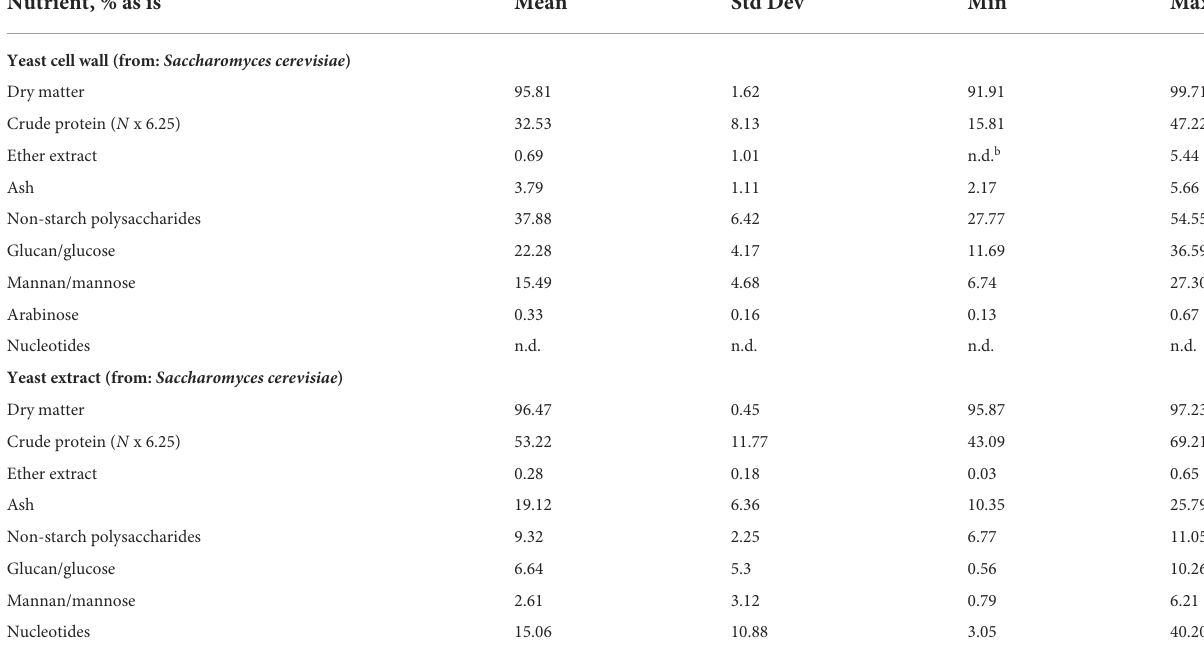
TABLE 2 Nutrient composition of yeast derivatives a . Nutrient, % as is